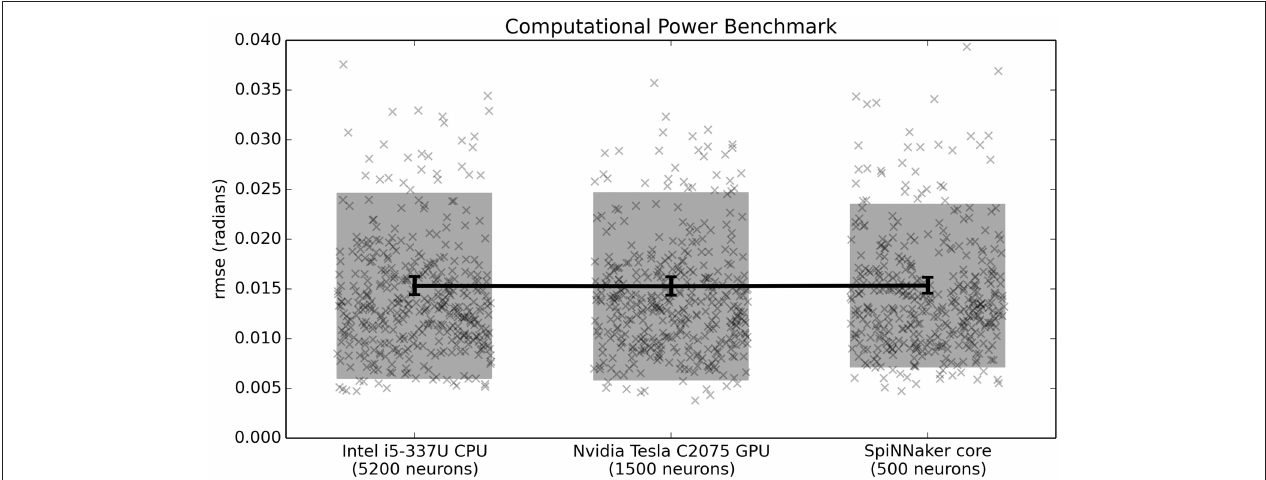
FIGURE 6 | Benchmark results comparing three hardware systems in terms of their performance when running as many neurons as they are capable of in real time. Scatterplots show individual runs (with random jitter on the x-axis to avoid overlap), the shaded area is the mean plus or minus the standard deviation, and the 95% confidence interval of the mean is shown. In this case, there is no statistical difference between the three hardware systems ( p > 0.05 ; two-tailed t -test with Bonferroni correction; 400 samples per condition).